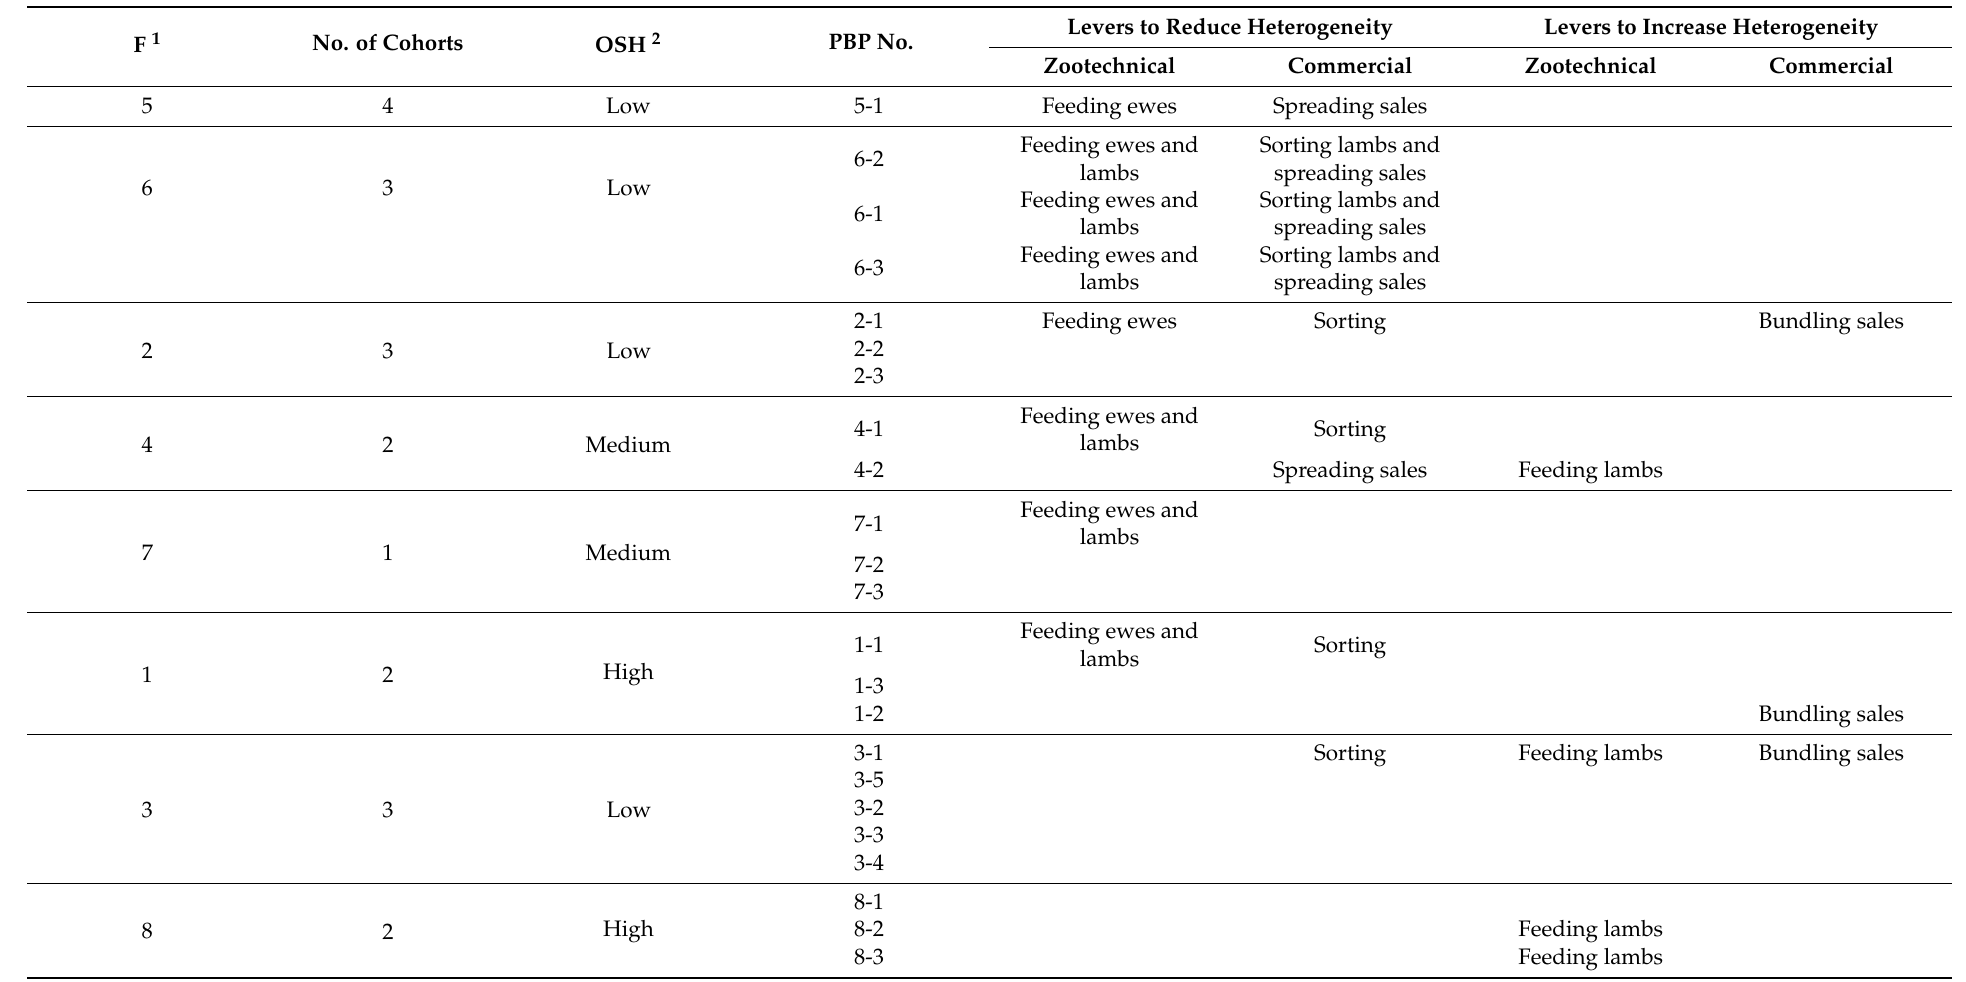
Table 5. Levers used to manage heterogeneity by the eight sheep meet farmers